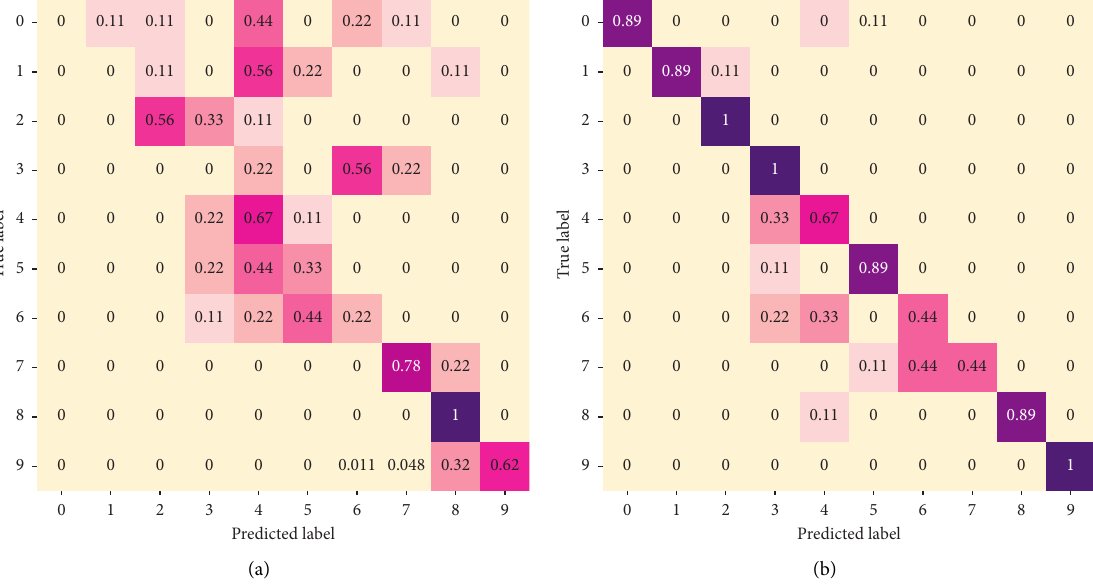
Figure 19: Confusion matrixes obtained from (a) original data and (b) processed data.